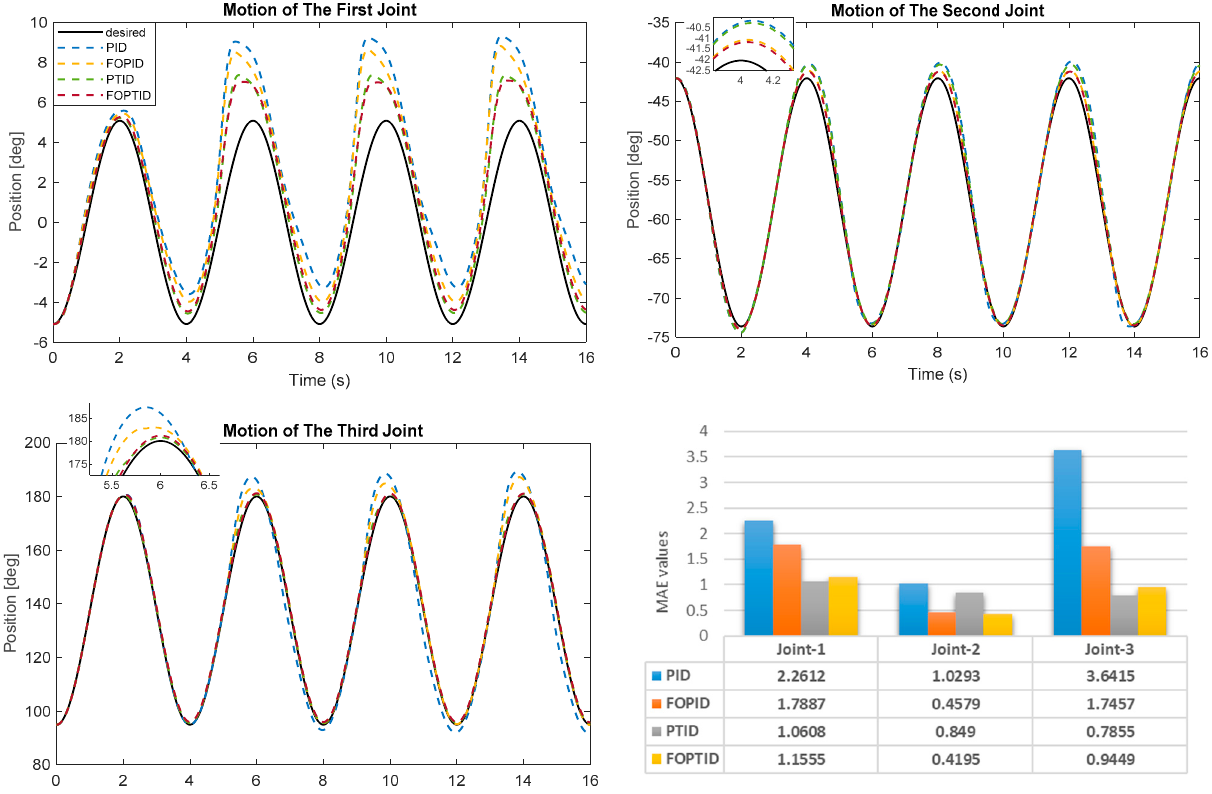
Figure 14. Comparison of disturbance rejection abilities and MAE values of joint angle tracking based on the designed controllers.